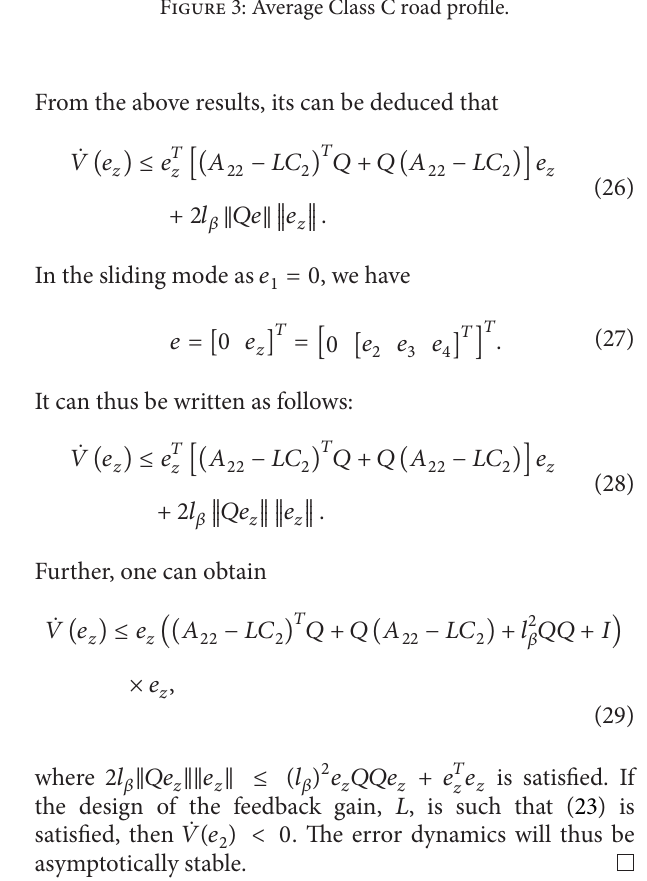
Figure 3: Average Class C road